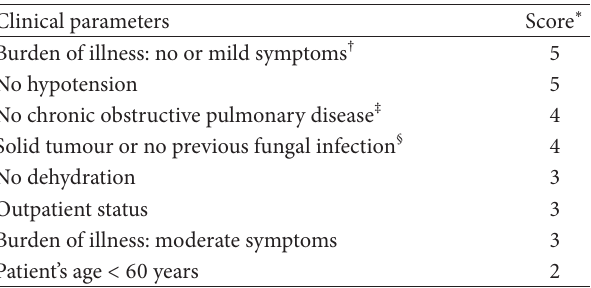
Table 1: MASCC score